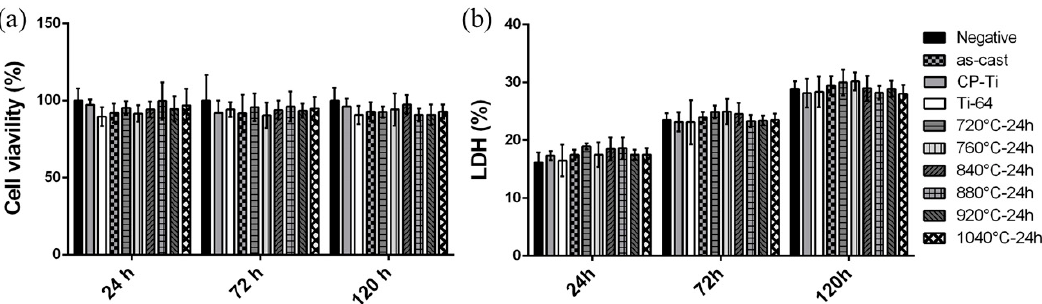
Figure 8. Cytotoxicity evaluation of the CP-Ti, Ti-64, and Ti-5Al-2.5Cu specimens annealed at various temperatures after 24, 72, and 120 h of incubation. ( a ) The tetrazolium bromide (MTT) assay and ( b ) lactate dehydrogensae (LDH) assay.